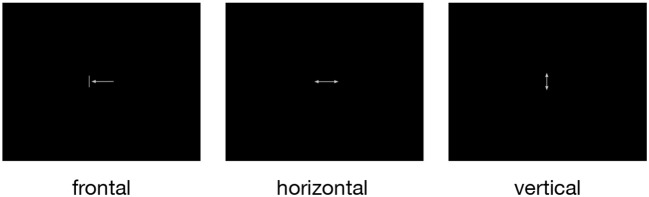
The three pictograms used to cue frontal (protrusion), horizontal (side to side), and vertical (elevation) tongue movements. All symbols were simple and small to minimize eye movements and visual processing. During rest periods, a small fixation cross was shown.